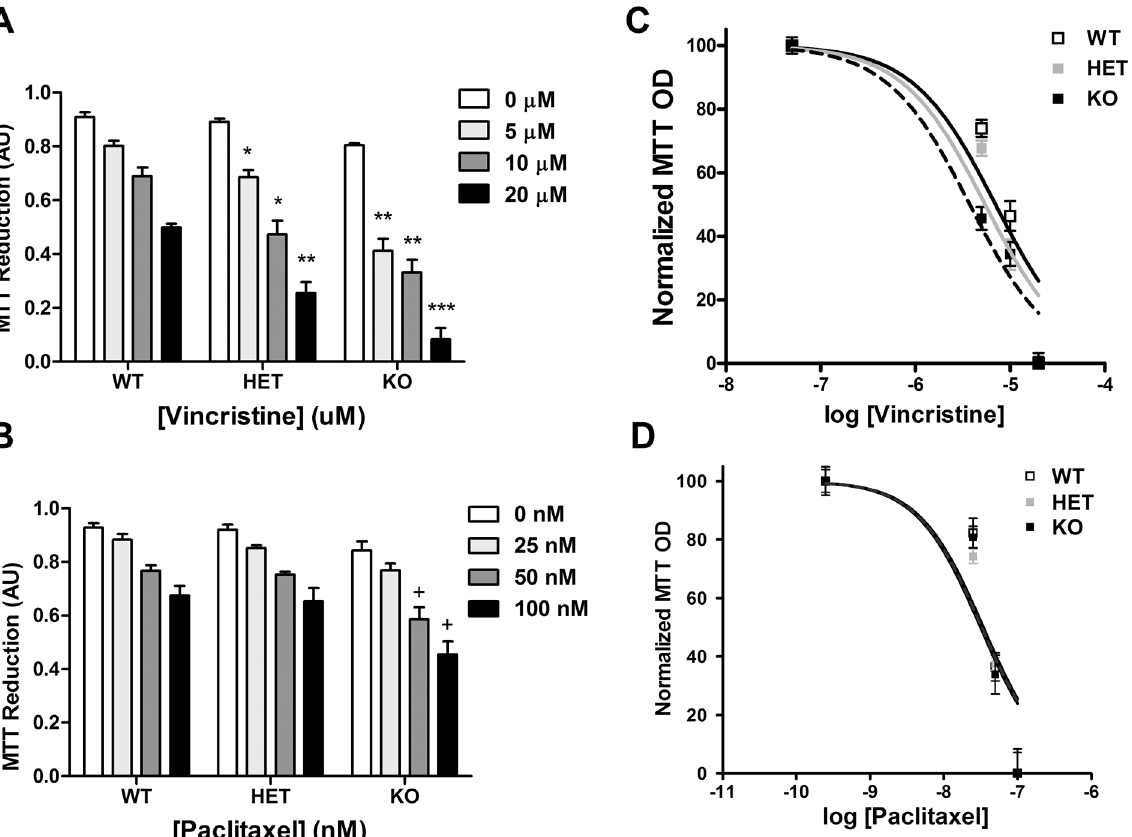
Fig 1. Treatment of NMNAT2-/- cortical neurons with vincristine and paclitaxel renders them hypersensitive to neurotoxicity. A) DIV14 cortical neurons (i.e. 14 days in vitro) from wildtype (WT), NMNAT2+/- (HET) and NMNAT2-/- (KO) mice were treated with increasing concentrations of vincristine for 12 hours. Vincristine dose-dependently reduced the viability of both NMNAT2+/- and NMNAT2 -/- neurons. NMNAT2-/- neurons were especially hypersensitive to vincristine-mediated toxicity. B) Treatment of these neurons with increasing concentrations of paclitaxel significantly reduced cell viability in NMNAT2-/- at higher concentrations only. Panels C) and D) represent normalized absorbance (OD) in MTT-treated primary neurons that were used to calculate EC 50 values for chemotherapy-induced reductions in cell viability in WT, HET and KO conditions. (n = 3 in at least three independent experiments; * p < 0.05, ** p < 0.001, *** p < 0.0001 vs. each corresponding genotype; +p < 0.05 vs.